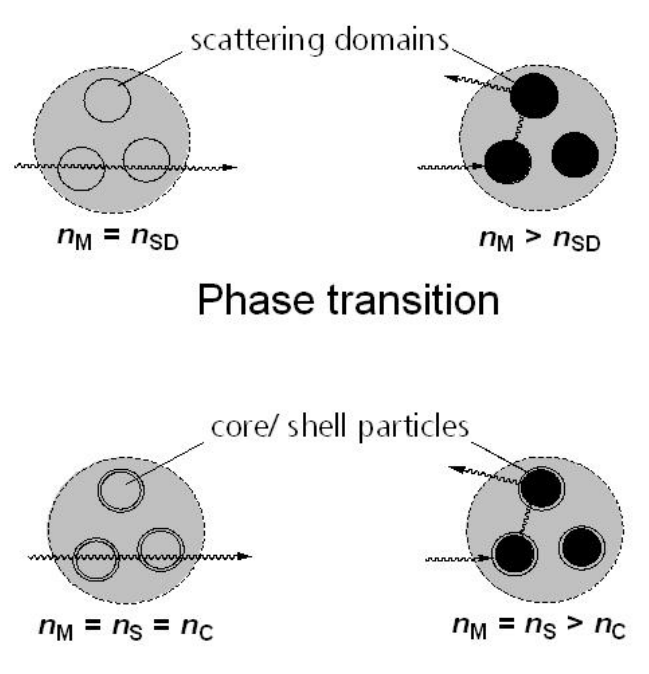
Figure 2. Approaches for thermotropic switching by phase